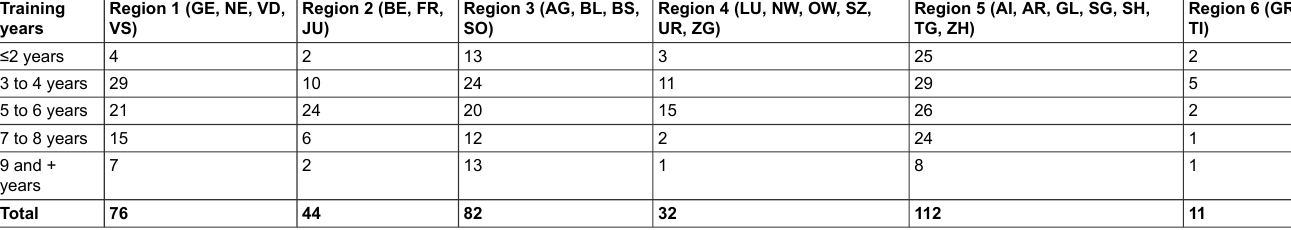
Table 4: Number of trainees according to the different areas of Switzerland in 2019. Training Region 1 (GE, NE, VD, years